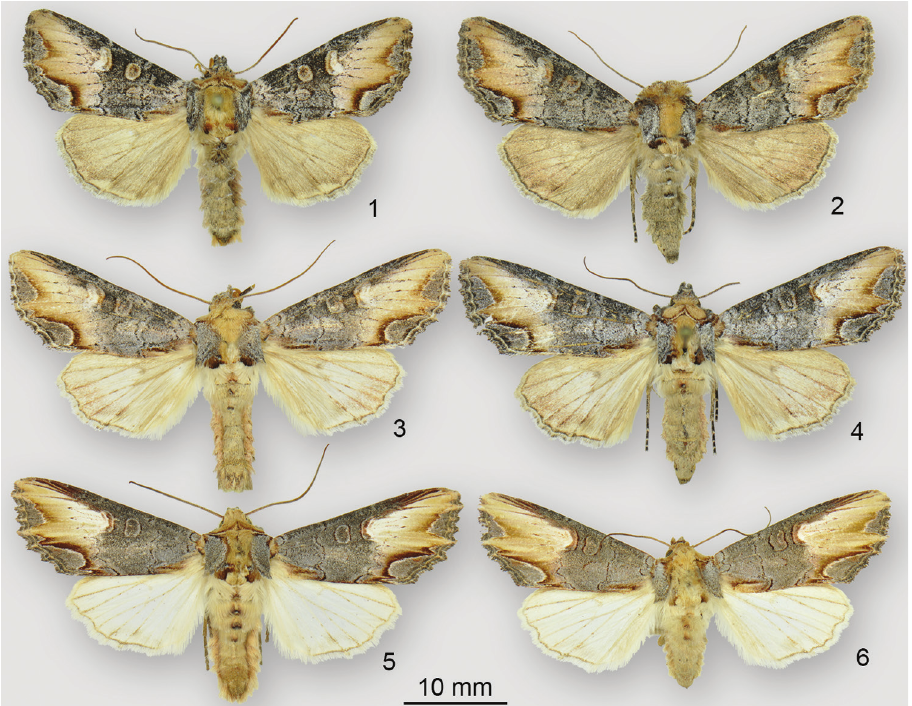
Figures 1–6. Admetovis adults . 1 A. icarus , Holotype male, USA, Colorado, Boulder County,